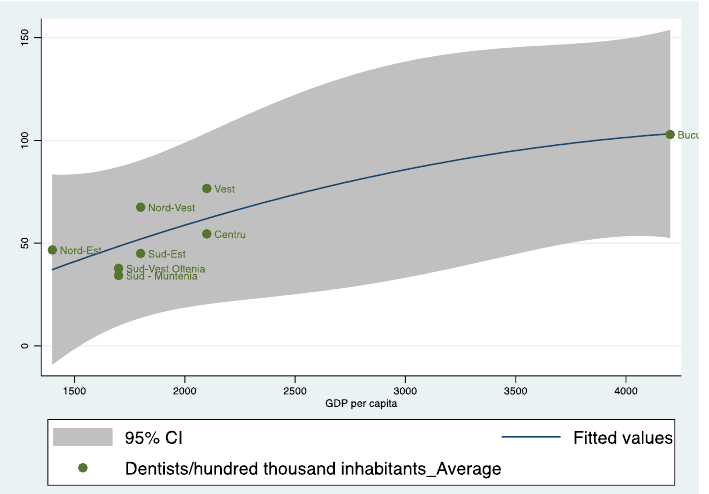
Figure 9. Dentists per one-hundred-thousand inhabitants and GDP per capita, averaged over the period 2001 – 2015. Source: computed by the authors based on the Eurostat database [23] using Stata 15.1.